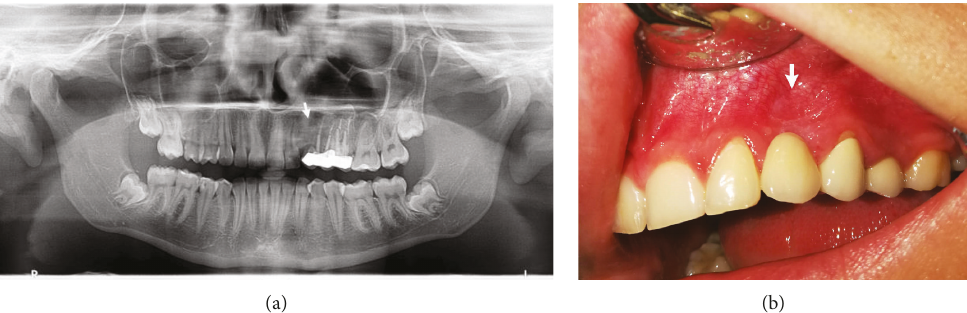
Figure 3: Follow-up period after 9 years. (a) An orthopantomogram (OPG) with no signs of radiolucency with satisfactory bone regeneration in the operated area (arrow). (b) Clinical appearance of vestibular mucosa with the presence of mild recess (arrow).